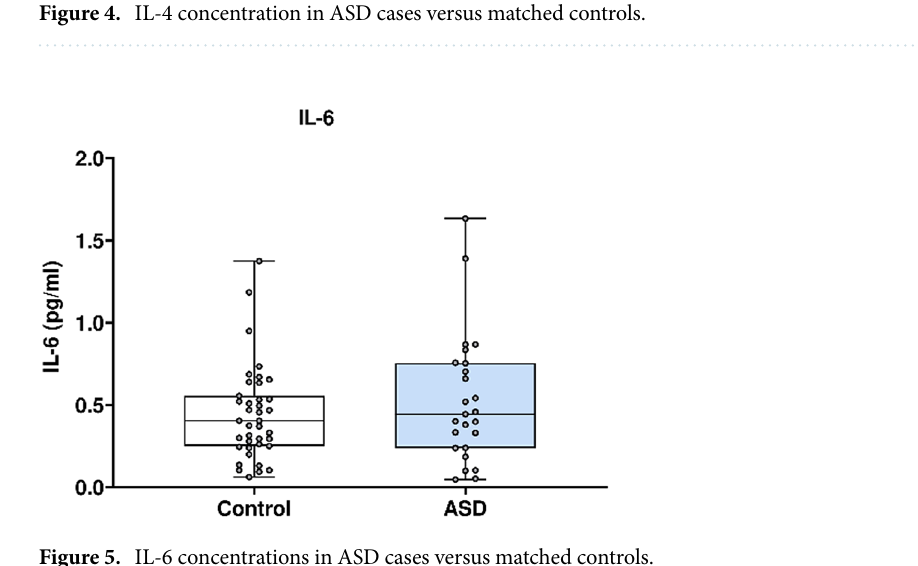
Figure 5. IL-6 concentrations in ASD cases versus matched